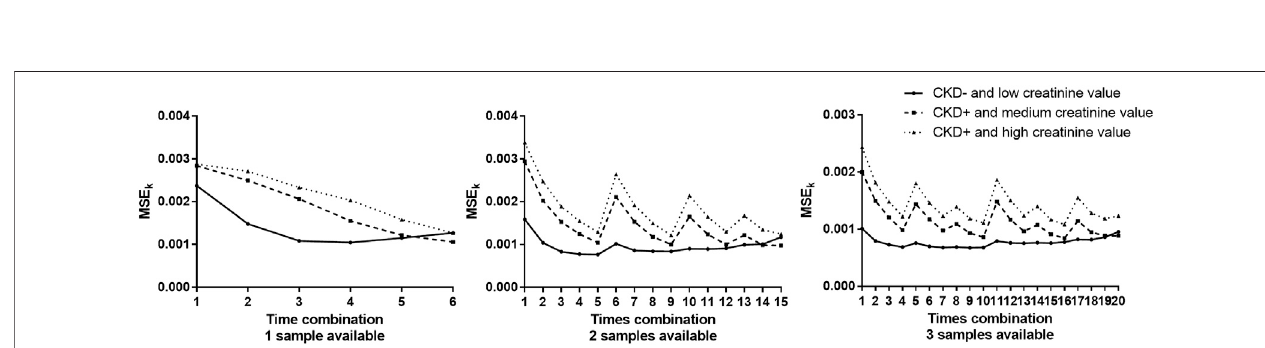
FIGURE 5 | Plots of mean square error for the time combination K (MSE K ) vs. time for the 3 dog examples (CKD − and low creatinine value, CKD+ and medium creatinine value and CKD+ and high creatinine) when 1, 2, or 3 samples were available (left, middle, and right, respectively ).